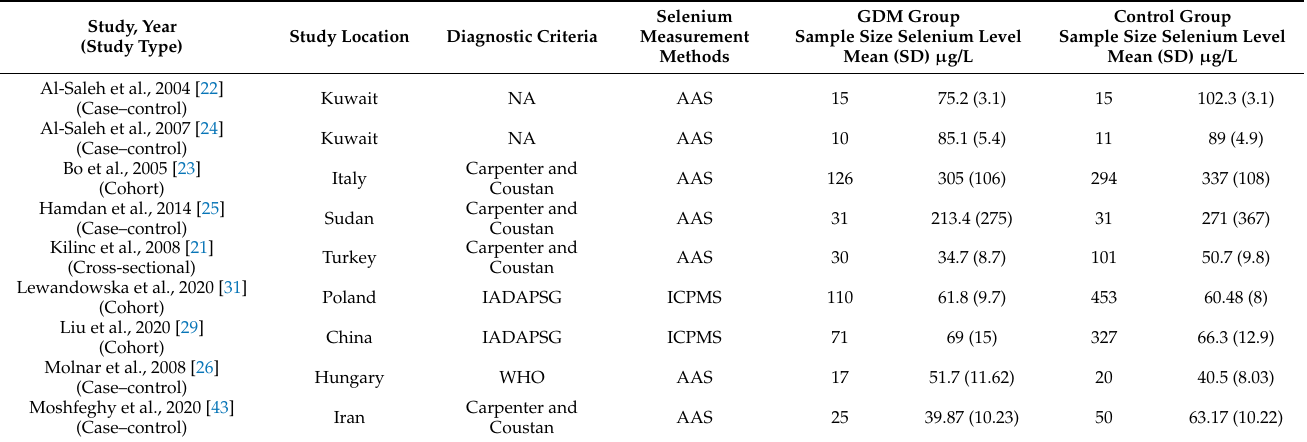
Figure 1. Flow diagram of the search process. Table 1. Features of studies investigating selenium levels included in the overall